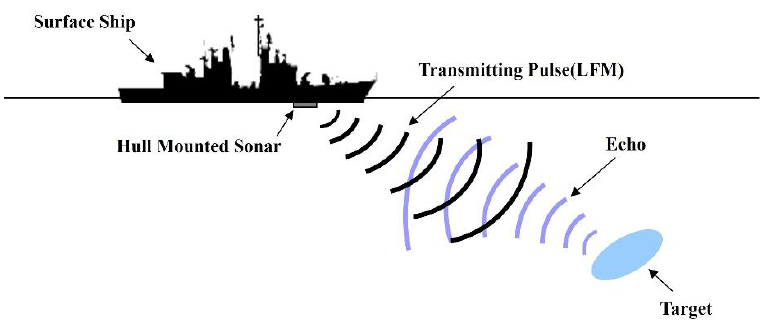
Figure 10. The environment of the experiments.